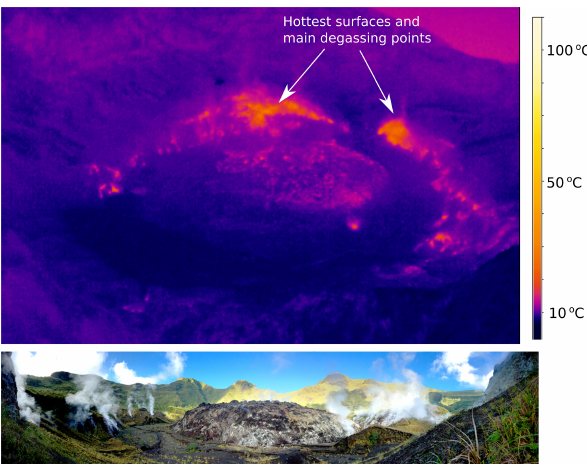
Figure 5. The lava dome and the conduit plug force the degassing to the crater wall. The hot surfaces (photo above) also correspond to the degassing points (picture